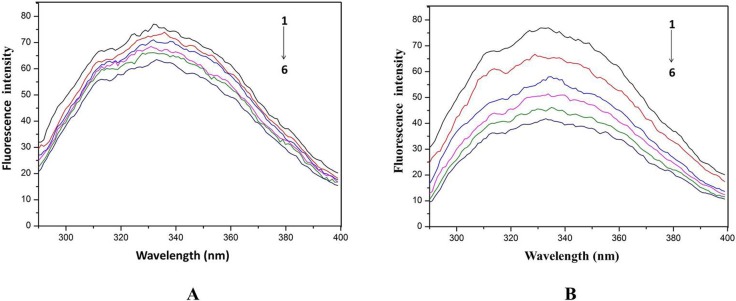
Effect of drug on fluorescence spectra of HSA.A: Effect of cordycepin on fluorescence spectra of HSA; the concentration of HSA was 1 μM while the cordycepin concentration corresponded to 0, 10, 20, 30, 40 and 50 μM (from 1 to 6). B: Effect of HEA on fluorescence spectra of HSA. The concentration of HSA was 1 μM while the HEA concentration corresponding to 0, 10, 20, 30, 40 and 50 μM (from 1 to 6).